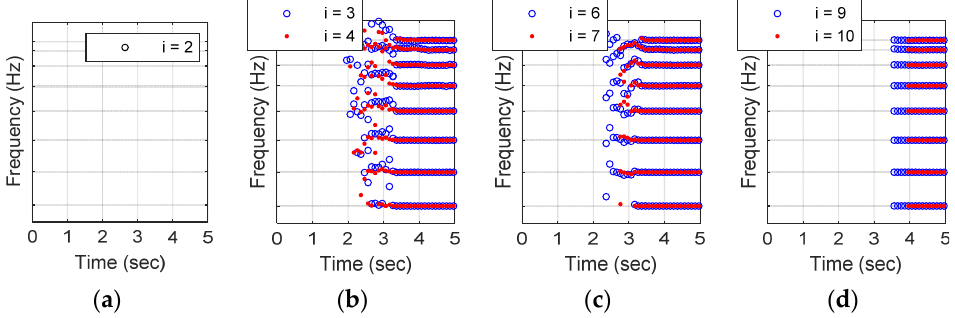
Figure 4. The identified modal frequencies across various C E ( C E = 0.78, 1.3, 1.57, 2.35, 2.75, 3.53, or3.92 when i = 2, 3, 4, 6, 7, 9, or10, respectively). ( a ) smallest i ; ( b ) first i group; ( c ) second i group; ( c ) third i group.